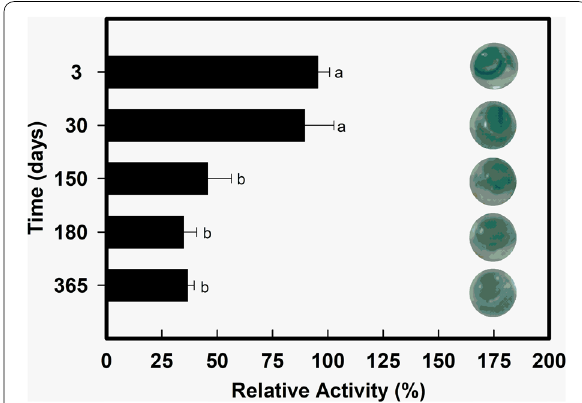
Fig. 6 Evaluation of long‑term stability. Reactions were performed with purified enzymes after the test, using 2,2 ′ ‑azino‑bis (3‑ethylbe nzothiazoline‑6‑sulfonic acid), ABTS, as substrates in the parameters set with optimum enzymatic activity (pH 4.0 and 37 °C). The tests were performed with 3 replicates. The small letters at the top indicate the significant difference between each condition performed in the experiment, according to ANOVA and Tukey test at 5%